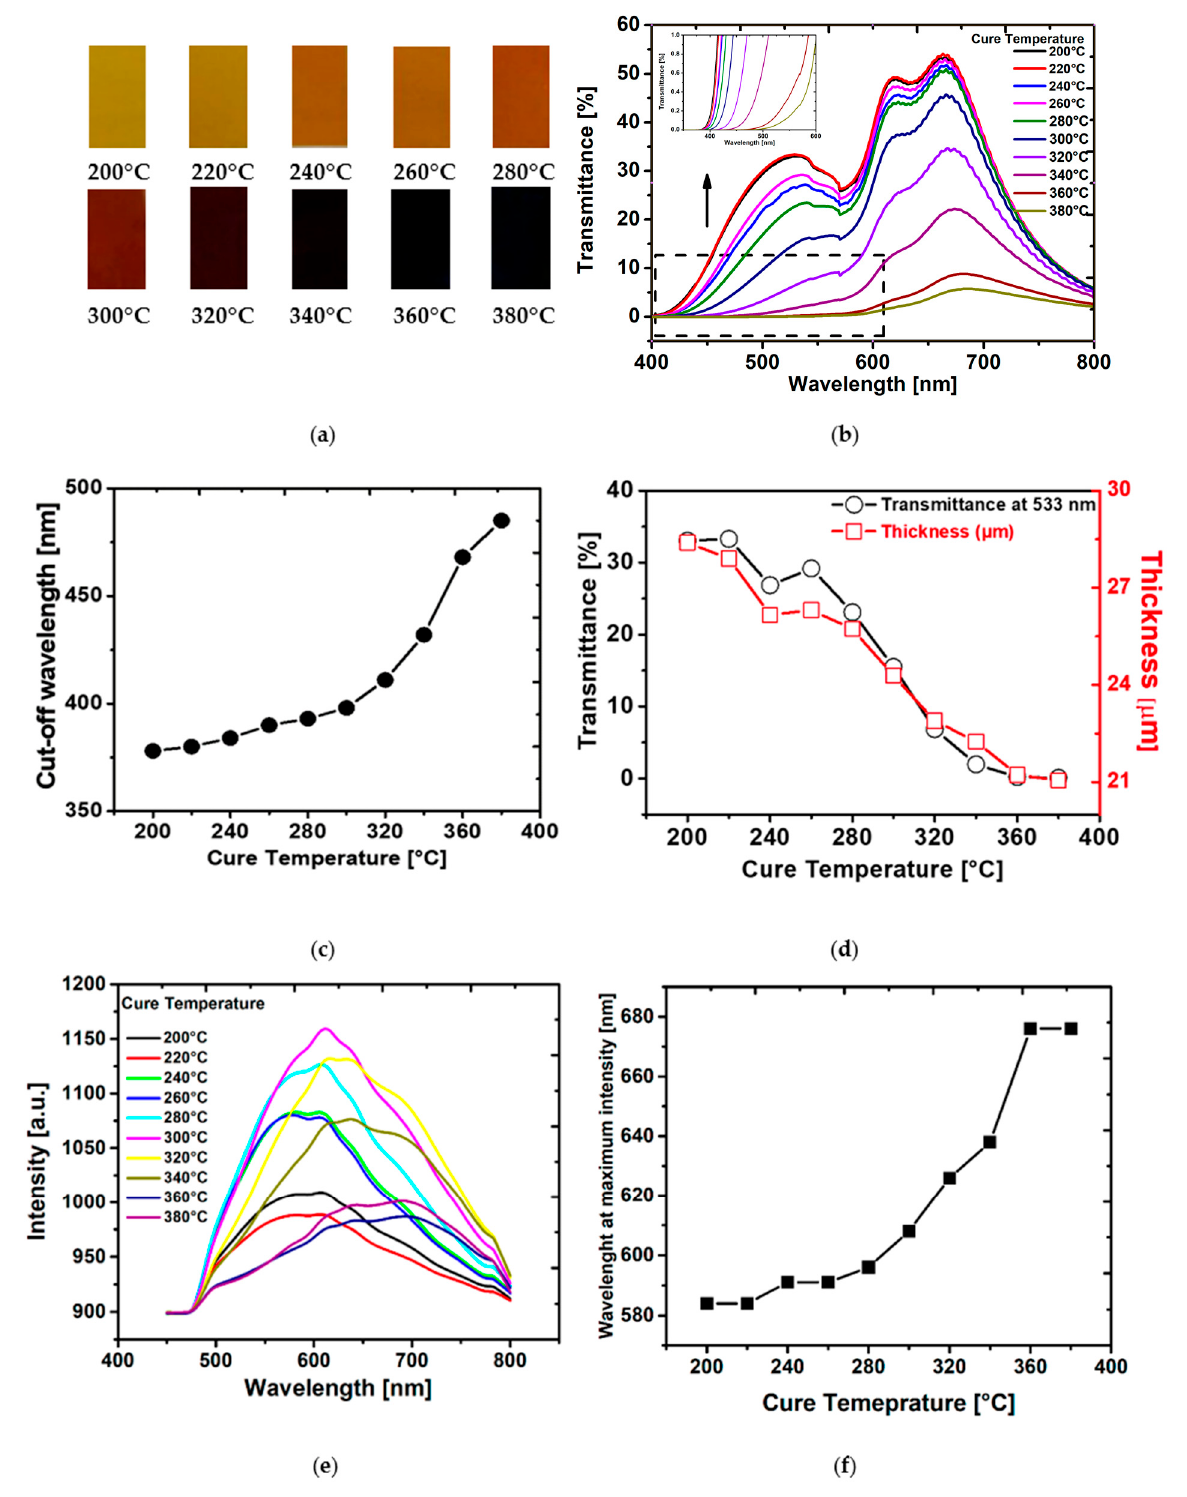
Figure 3. ( a ) Color shade of the PI films baked at different temperatures. ( b ) Transmittance in UV–vis spectroscopy of the PI films cured at different temperatures. ( c ) Cut-off wavelength for polyimide films. ( d ) Comparison between the transmittance at 533 nm with the PI films thickness changes as a function of cure temperature. ( e ) Steady-state photoluminescence spectra with excitation wavelength of 405 nm observed for PI films thermally cured at different temperatures. ( f ) Effect of cure temperature on the red-shift of the fluorescence spectrum of